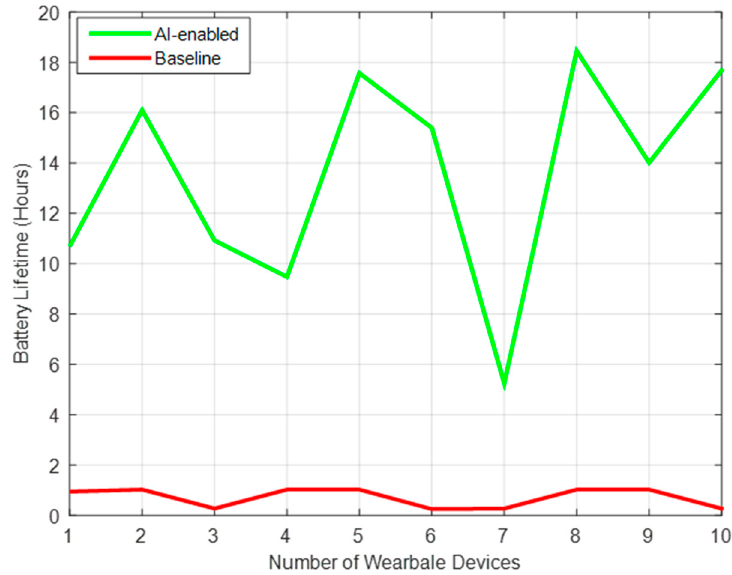
Figure 3. Battery Lifetime and Authentication level of IoT devices.